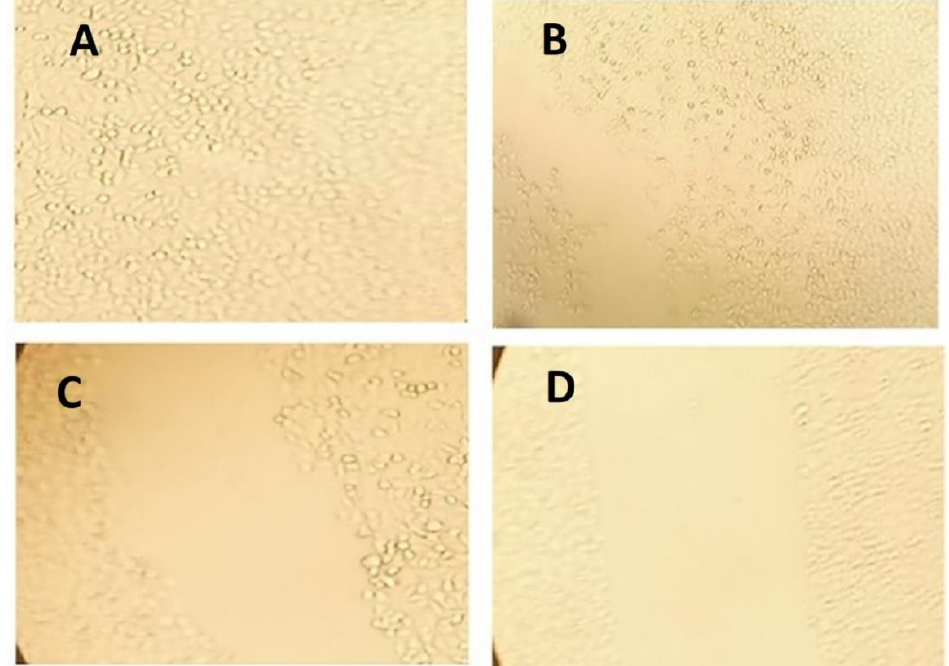
Figure 10. Wound coverage results of ( A ) untreated cells, ( B ) cells treated with blank-BZ, ( C ) cells treated with PIC-raw, and ( D ) cells treated with optimized PIC-BZ with 40x magnification.